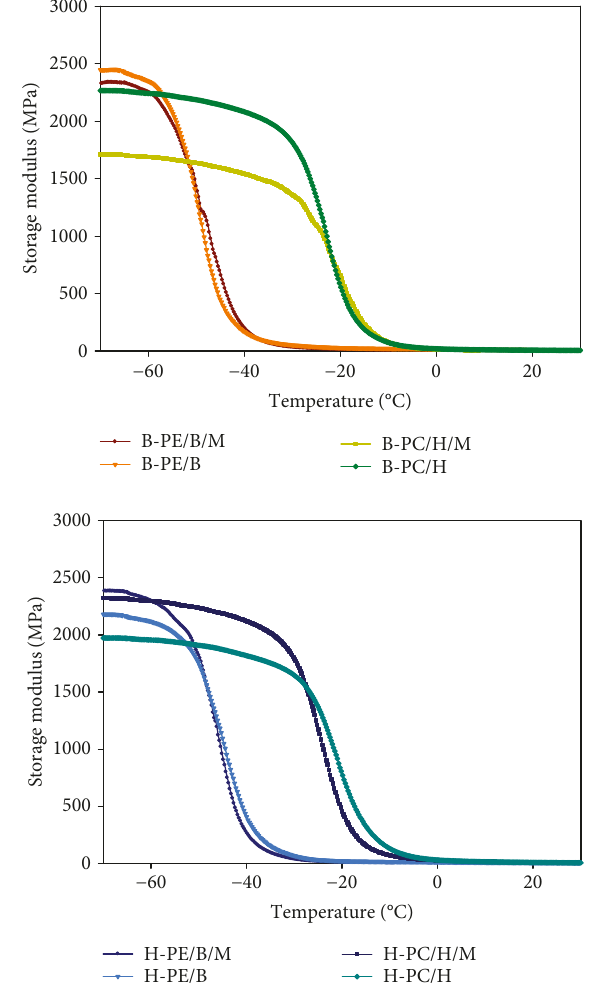
Figure 4: Storage modulus of polyurethane fi